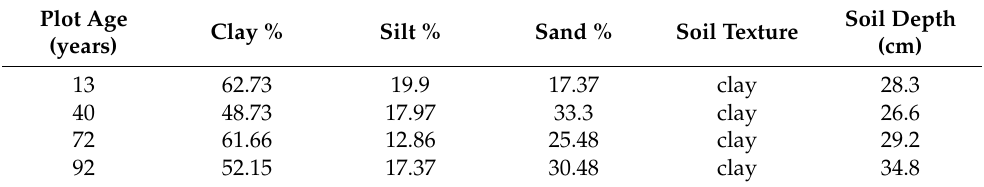
Table A1. Soil texture and depth in each study plot.